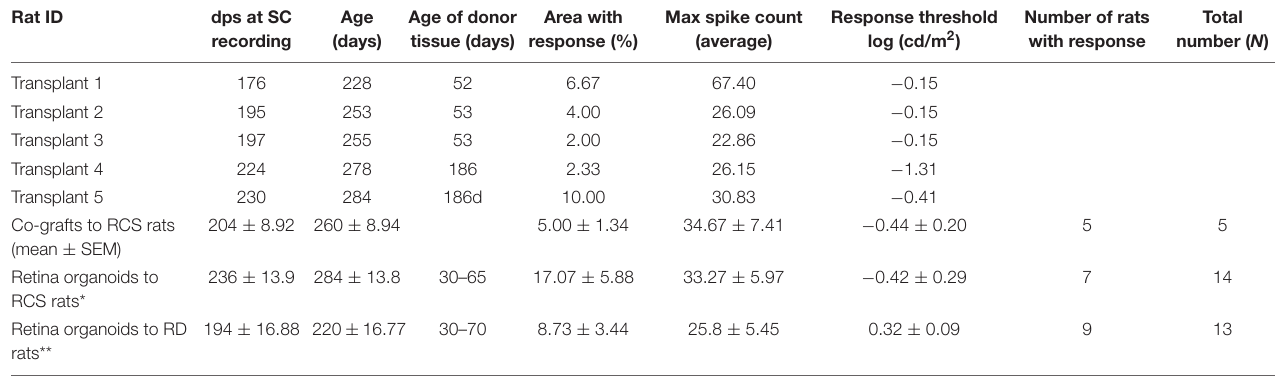
TABLE 3 | Superior colliculus recording data of RCS rats transplanted with co-graft or retina organoid.